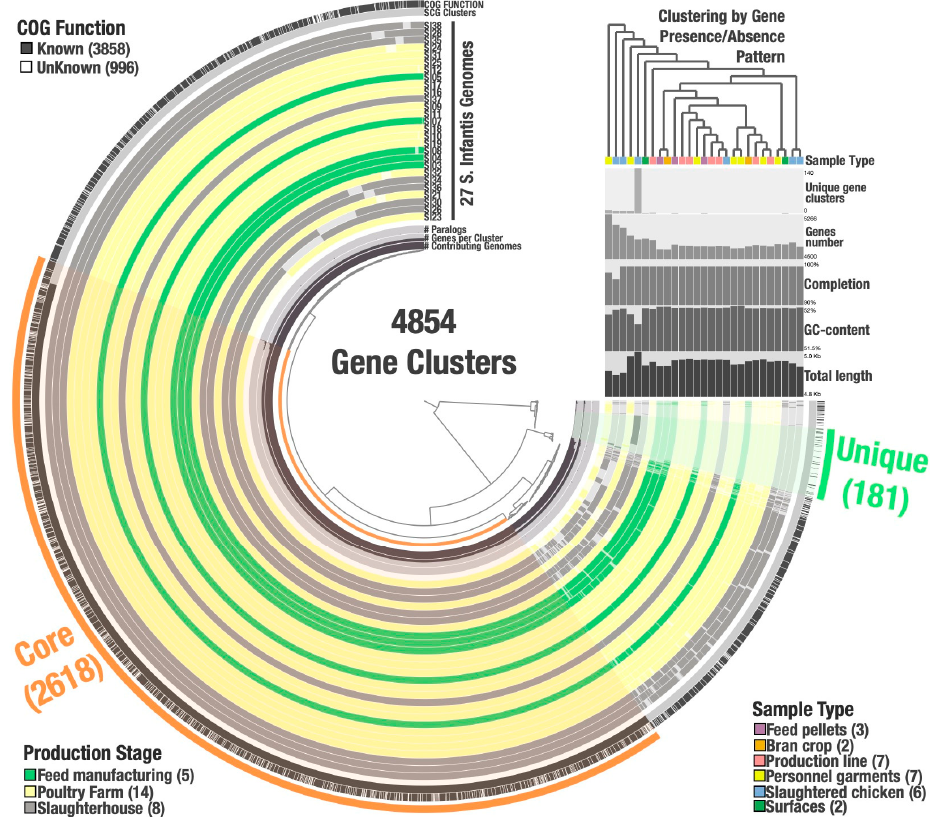
Figure 5. The pangenome of S. Infantis. Each of the 4854 gene clusters contains genes contributed by one or more isolate genomes. Gene clusters are organized based on their distribution across genomes (defined by the tree in the center), and genomes are organized in radial layers based on Euclidian distance and Ward ordination of the gene clusters they share. Visualization described from the inside out: the first three layers show (1) the number of genomes in which the corresponding cluster is present; (2) the number of genes in the corresponding cluster, and (3) the number of paralogs in the corresponding cluster. The middle 27 layers are the genomes, and the bars indicate the occurrence of a given gene cluster in that strain, colored by their origin on the production stage. The top two outside layers describe (1) the single copy core-gene clusters for the 27 genomes and (2) the gene clusters in which at least one gene was functionally annotated using COGs. Finally, the outside selections correspond to the Core gene clusters (2618), and those present exclusively in one strain (Unique: 181). The upper-right section provides additional data for each genome (from bottom to top): genome total length, GC-content (%), completion (%), number of genes, number of unique genes, the genome classification based on sample type origin and the dendrogram at the top depicts the hierarchical clustering of genomes based on the occurrence of gene